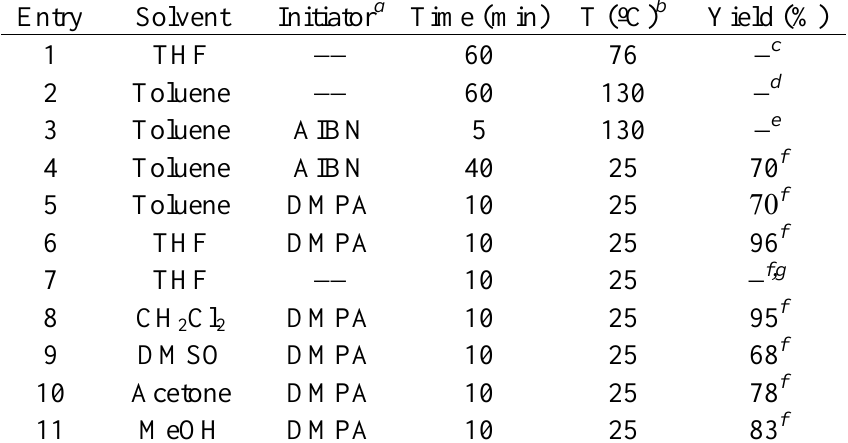
Table 1. Thiol-ene coupling reaction between 1 and 2 under different